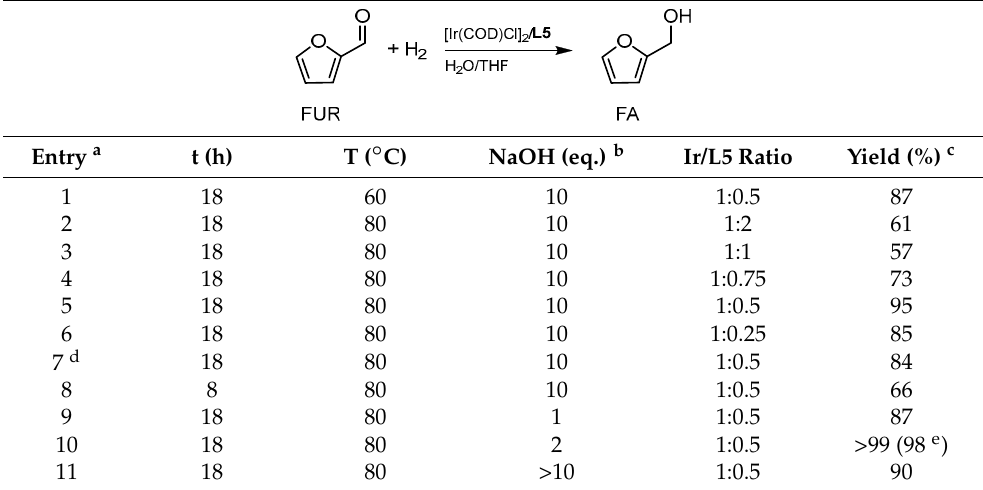
Table 2. Optimisation of the [Ir(COD)Cl] 2 / L5 system for the hydrogenation of FUR to FA.